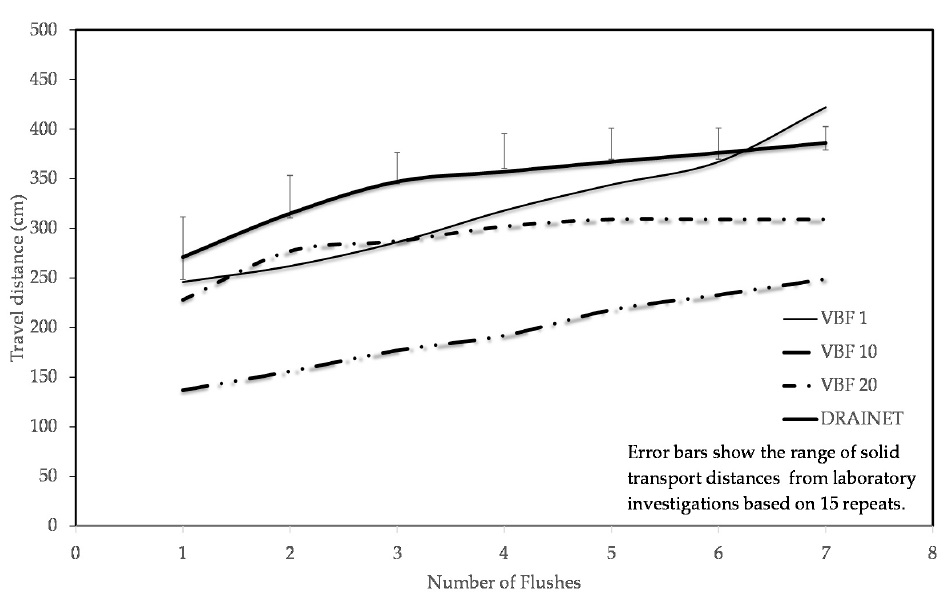
Figure 9. Effect on solid transport of changing the ViscoBoundFactor. Results shown in comparison to DRAINET and results from laboratory investigations for the case where the specific gravity was 1.1.